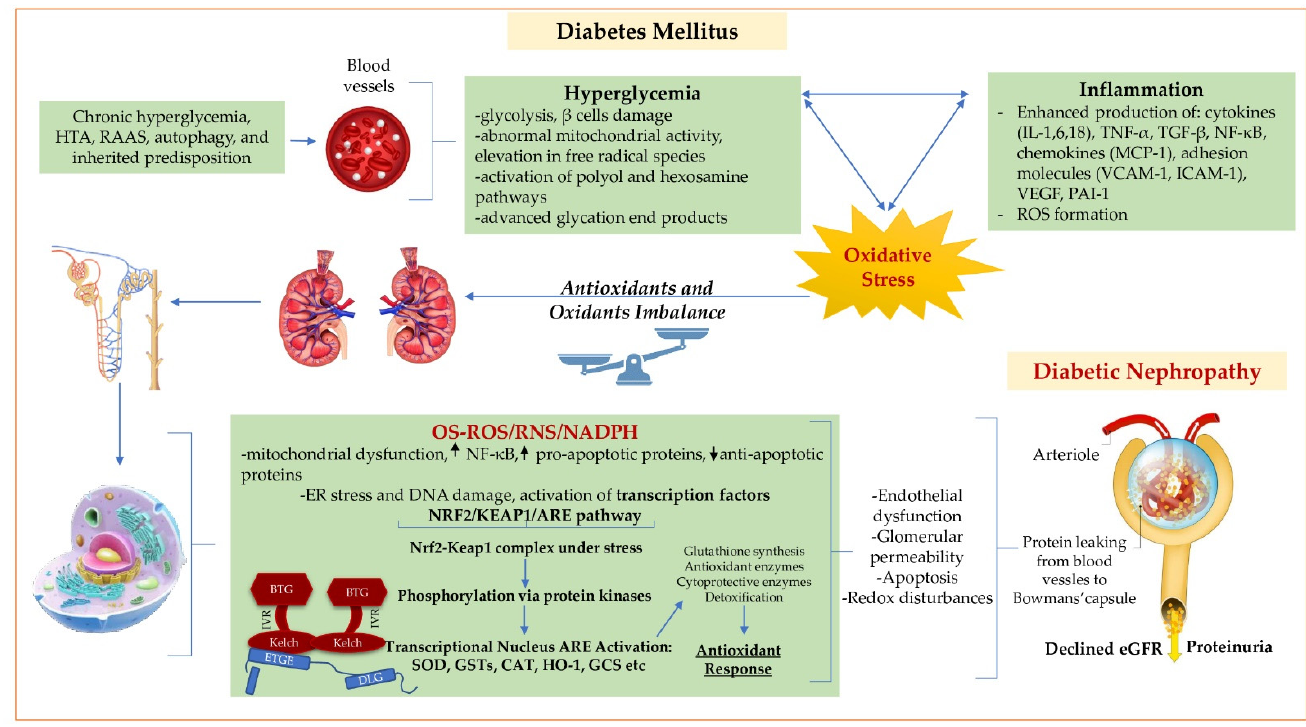
Figure 1. Role of oxidative stress and NRF2/KEAP1/ARE pathway in the multiplex diabetic nephropathy pathophysiology. DM associated with multifarious risk factors through persistent hyperglycemia, inflammation and OS, can instigate renal integrative glomerular barrier complex dysfunction (IGBC). IGBC is mainly formed by endothelial cells, the glomerular basement membrane (GBM), podocytes, tubular epithelial and mesangial cells. Each of these cells under influence of the disruptive mechanism mentioned above, produce factors and activate intricate pathways that have individual or entangled repercussion, which finally leads to impairment of the renal filtration unit. The major targets of OS are the fenestrated glomerular endothelial cells and the podocytes cells. Here, ER and mitochondrial stress enhances transcriptional activation of the NRF2/KEAP1/ARE pathway which can lead to a beneficial antioxidant response.